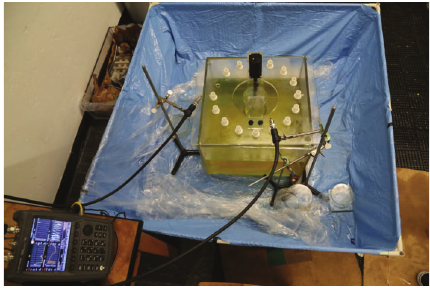
Figure 6: Photograph of the measurement setup showing the stepper motor to rotate the phantom and holders to position the transmitting and receiving antennas. [The antennas are not attached to holders in this photograph.]